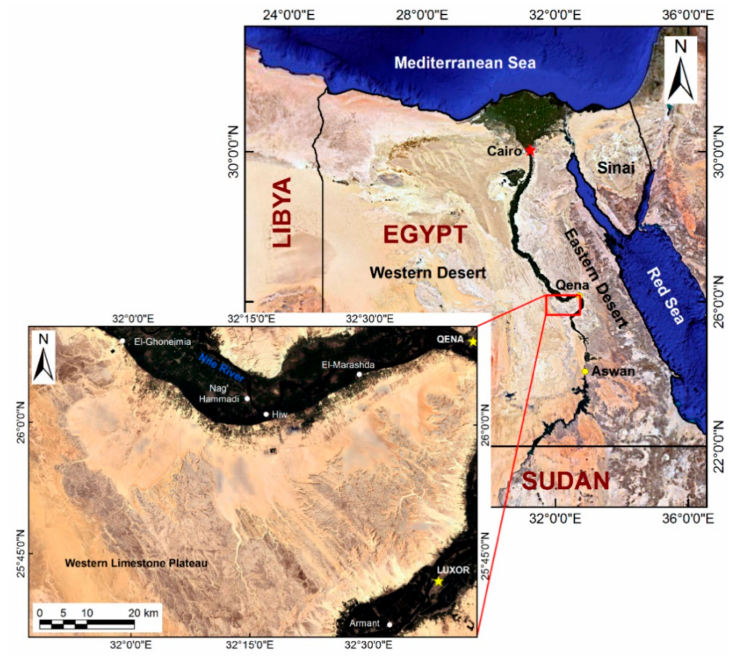
Figure 1. Location map of Egypt and West Qena